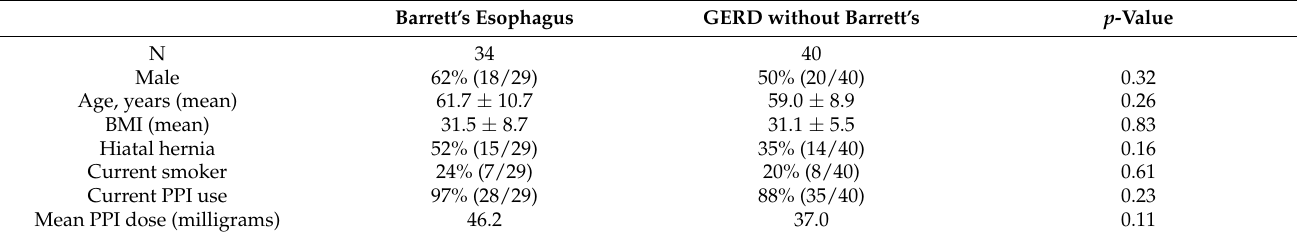
Table 1. Esophageal microbiome cohort demographics